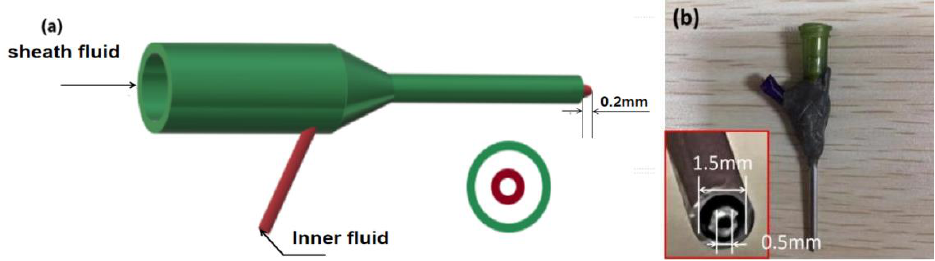
Figure 2. Structure of the homemade coaxial spinneret: ( a ) Diagram of the designed structure of the coaxial spinneret; ( b ) coaxial spinneret and the head of the spinneret (bottom-left insert). The experimental group consisted of two fluids as the core and sheath solutions for coaxial electrospinning. For the core solution, 3% ( w/v ) PEO solution was prepared by adding 3 g PEO to 100 mL of 80% v/v ethanol aqueous solution and stirring with a magnetic stirrer for 8 h. For the sheath solution, 28% ( w/v ) zein solution was prepared by dissolving 28 g zein in 100 mL of 80% v/v ethanol aqueous solution and stirring with a magnetic stirrer for 8 h. Adjusting the content of ferulic acid in the core or sheath solution allowed us to set up control groups. The detailed parameters are shown in Table 1 below.